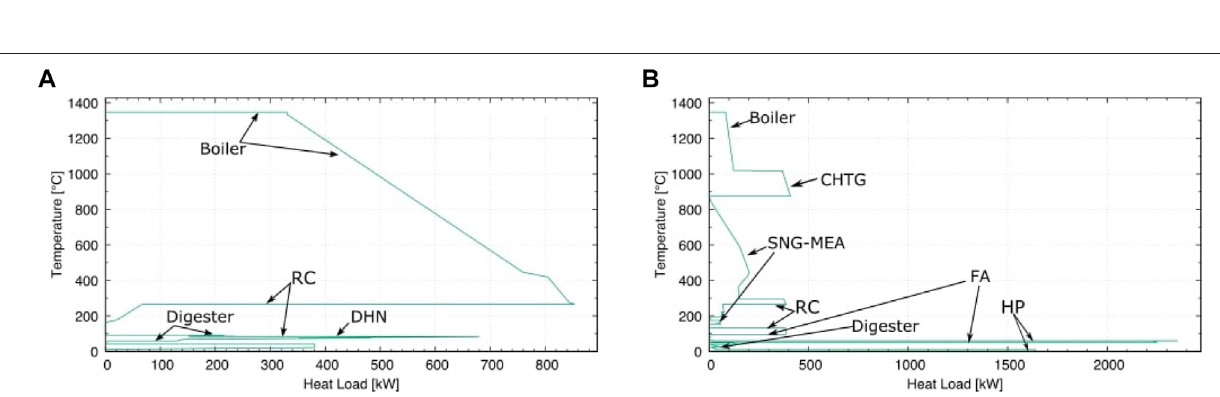
Frontiers in Energy Research |